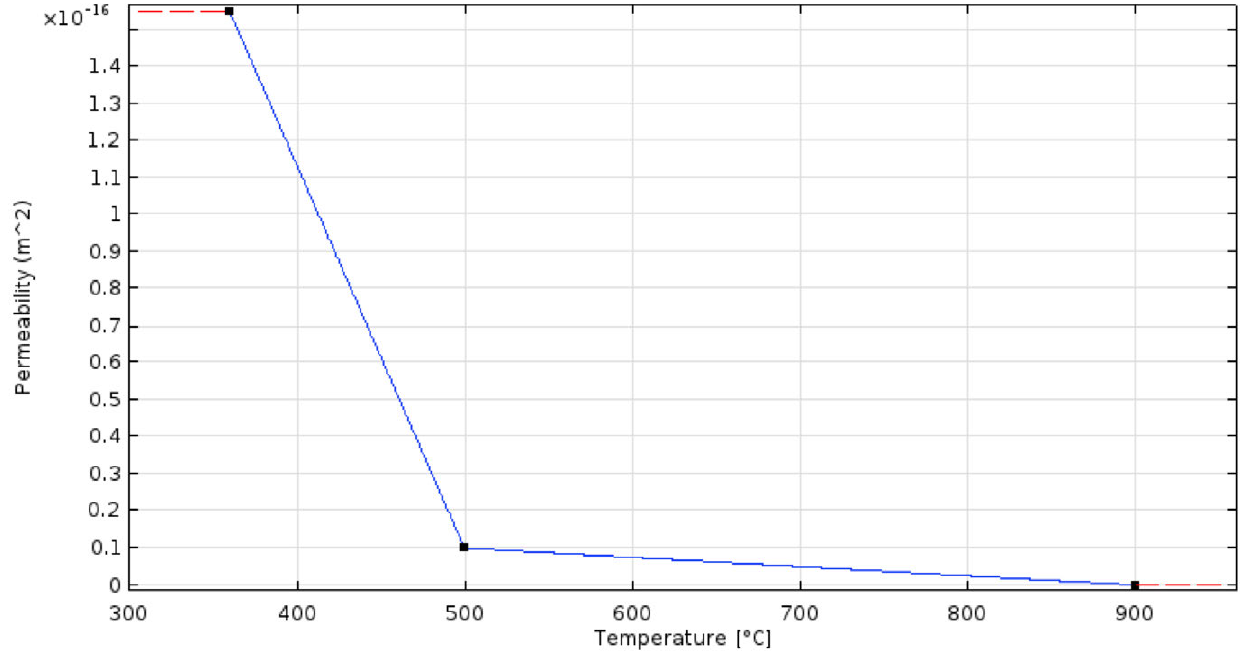
Figure D4: Permeability of magmatic intrusions as a function of temperature as used in the numerical models. Above the solidus ( T > 900 °C), intrusions are assumed to be impermeable, and the permeability is set to a low value of k = 10 − 22 m 2 . Between T = 500 °C and T = 900 °C, permeability is assumed to decrease linearly with increasing T from a value of k = 10 − 17 m 2 to a value of 10 − 22 m 2 [Hanson and Barton 1989; Hayba and Ingebritsen 1997]. Between T = 360 °C and T = 500 °C, permeability is taken to decrease linearly from k = 10 − 16 m 2 to k = 10 − 17 m 2 with increasing T due to fracture formation in the intrusions [Foumier 1991; Hayba and Ingebritsen